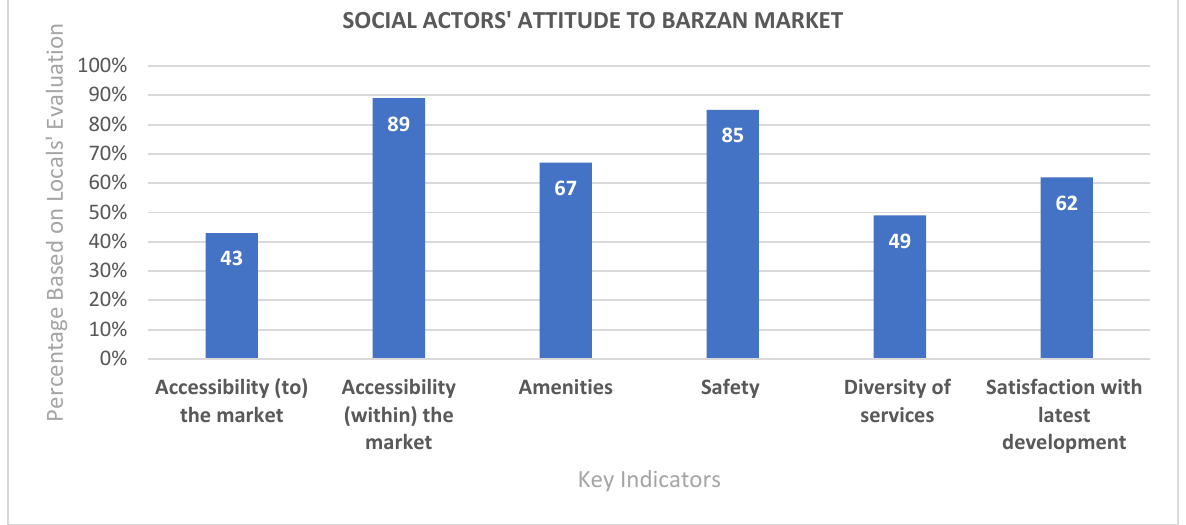
Figure 13. Social attitude assessment.